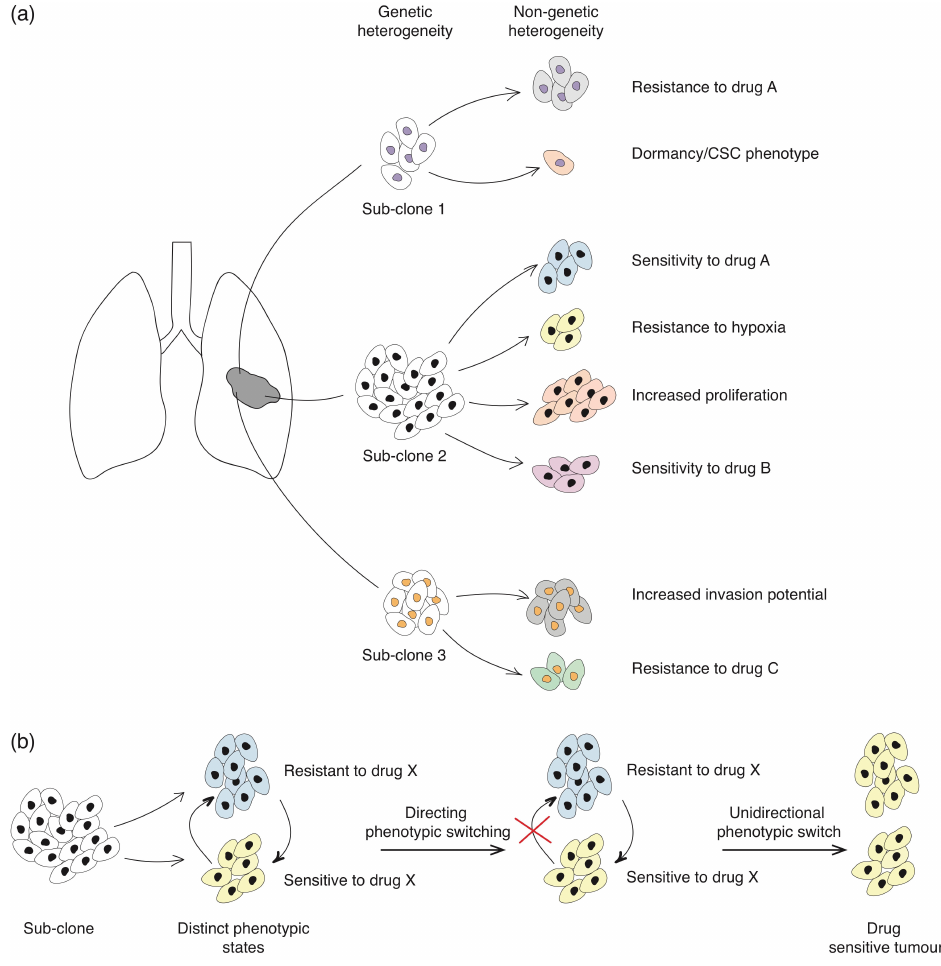
Figure 4. Genetic and non-genetic heterogeneity and their functional relevance in cancer evolution. ( a ) Cancer cell populations may be characterized by extensive genetic and non-genetic